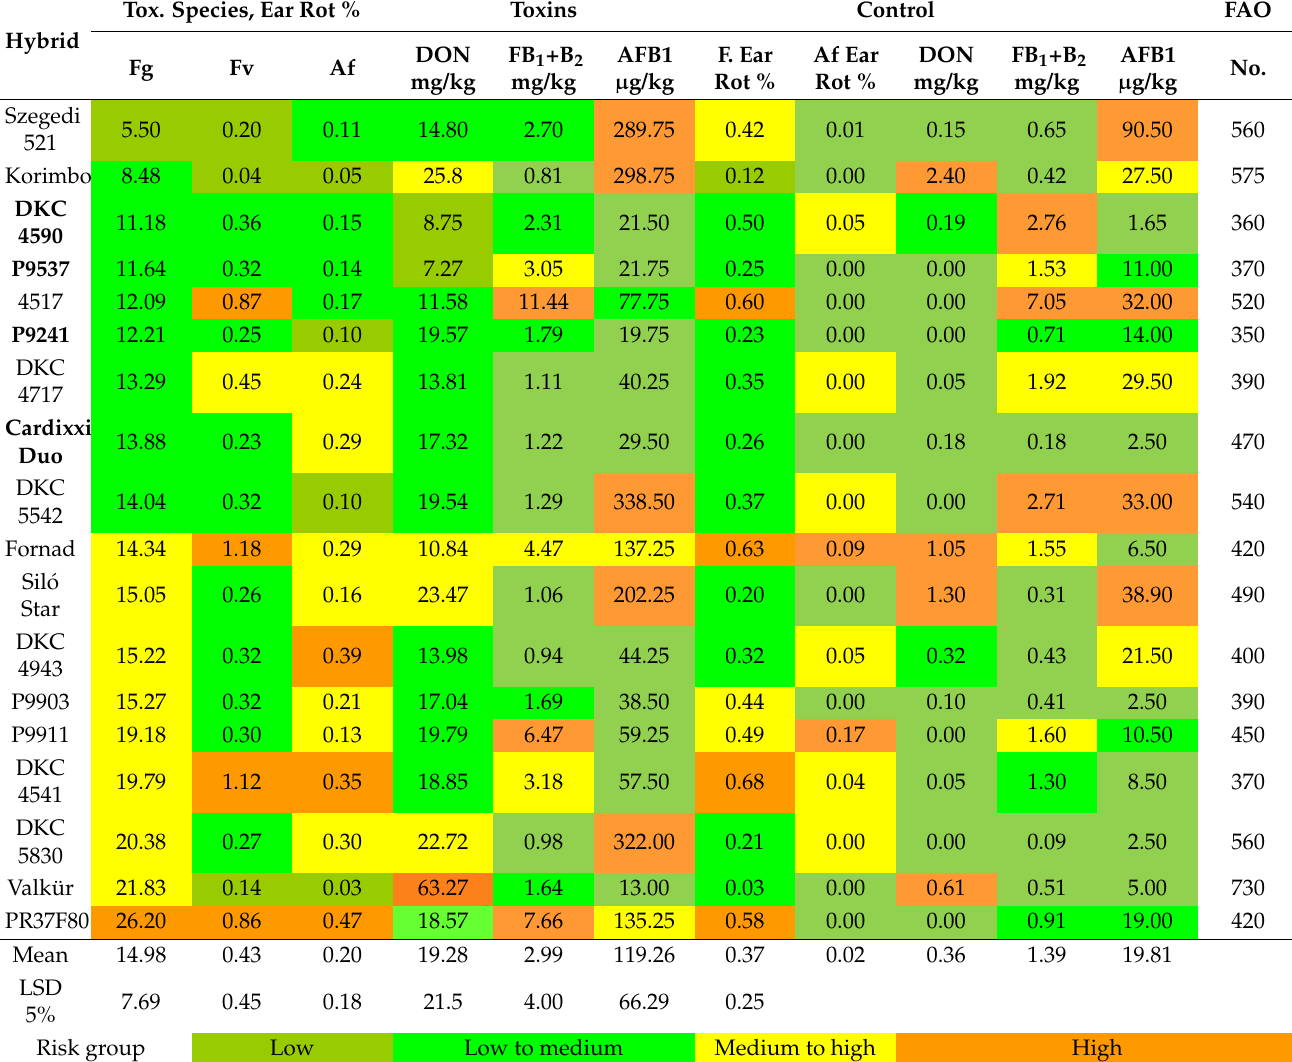
Table 4. Summary table of the 2017–2018 kernel resistance tests of maize hybrids, ear rot severities, and toxin contamination at artificial and natural inoculation